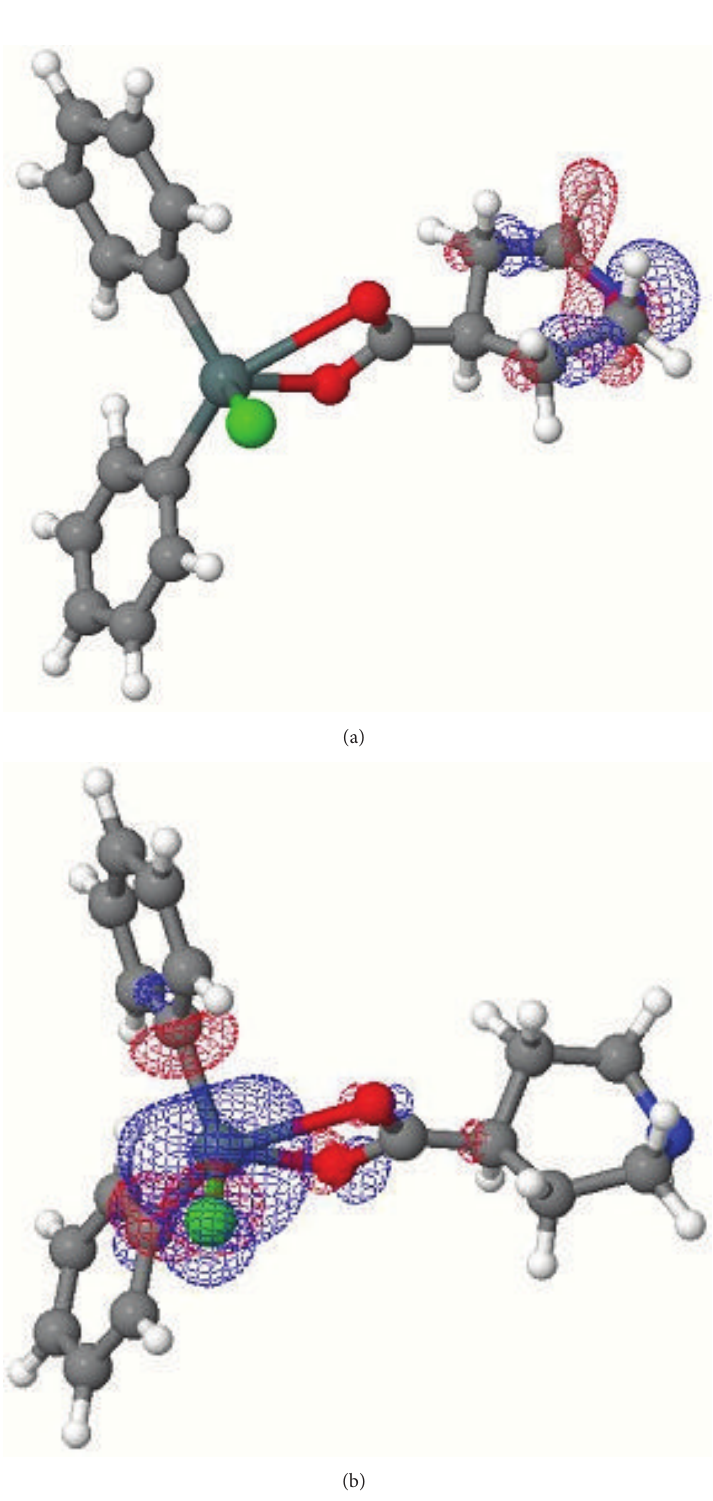
Figure 3: (a) HOMO of complex 3 ; (b) LUMO of complex 3